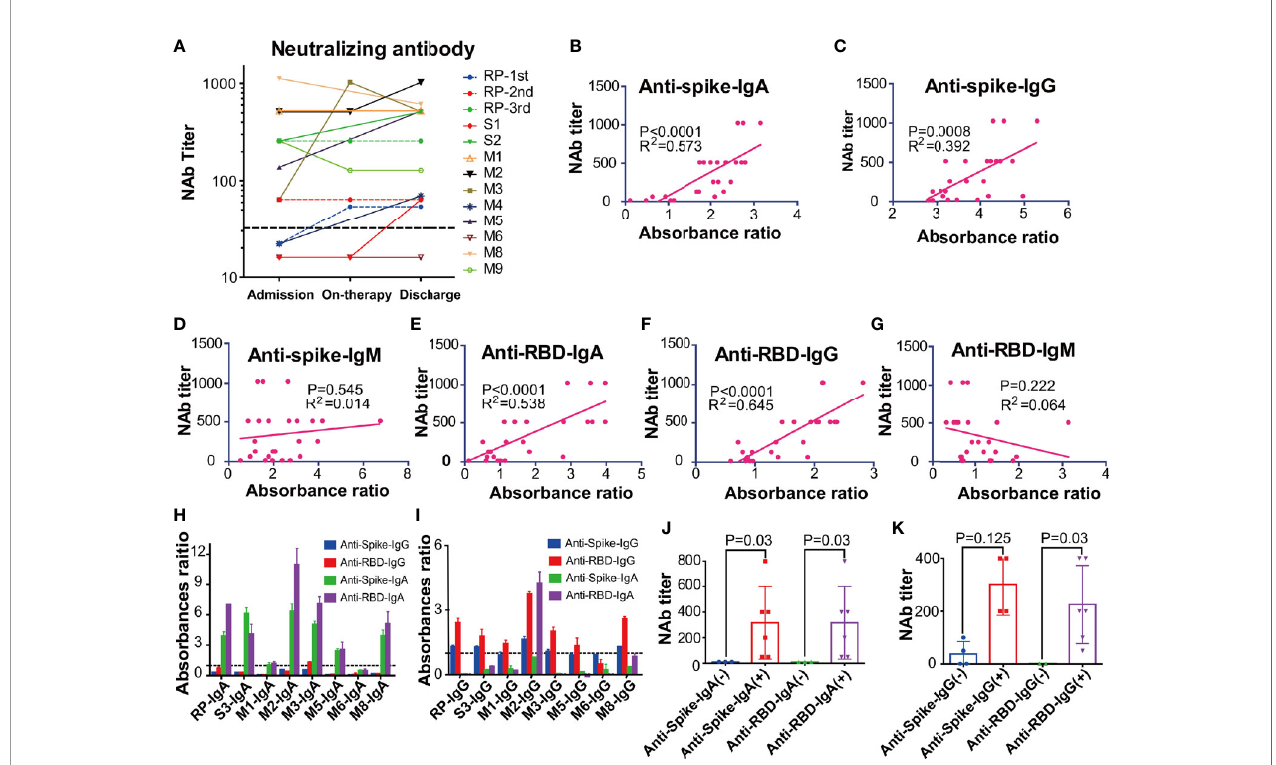
FIGURE 4 | The kinetic and correlation of anti-SARS-CoV-2 antibody and neutralizing antibody (NAbs) of all COVID-19 patients. (A) The dynamic change of the neutralizing antibody (NAbs) of all COVID-19 patients. (B – G) The correlation between NAbs level and anti-spike IgA(B), anti-spike IgG (C) , anti-spike IgM (D) , anti- receptor-binding domain (RBD) IgA (E) , anti-RBD IgG (F) , anti-RBD IgM (G) in all COVID-19 patients. The cut-off for the pseudovirus neutralization assay is 1:50. (H – I) The absorbance ratios of anti-spike an anti-receptor binding domain (RBD) speci fi c antibody in the isolated total IgA (H) and IgG (I) , that were calculated by the absorbance value of antibody isolated samples divided by 2.1 × mean absorbance value of anti-SARS antibody-negative samples (M6). (J) The neutralization antibody (NAbs) titers of the anti-spike/anti-RBD antibody IgA positive and negative groups. (K) The neutralization antibody (NAbs) titers of anti-spike/anti-RBD antibody IgG positive and negative groups. RP, re-tested positivity; MM, Mild-to-moderate; S,